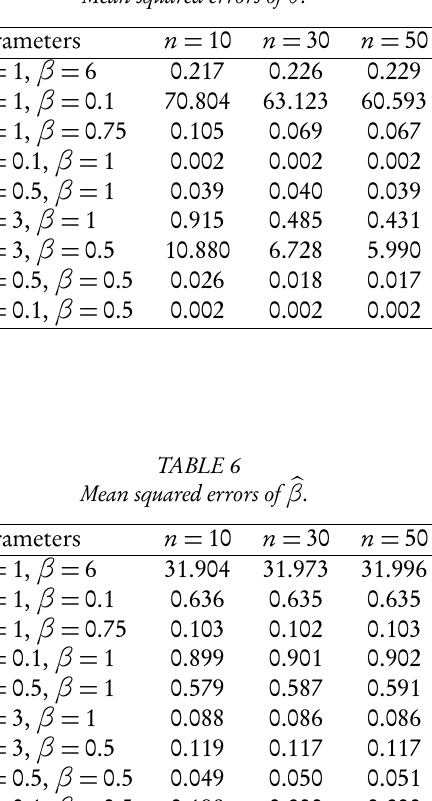
Mean squared errors of (cid:98) θ .